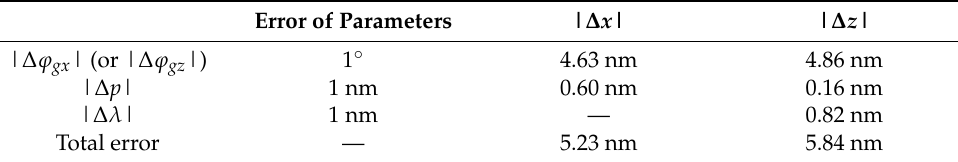
Table 3. Theoretical measurement